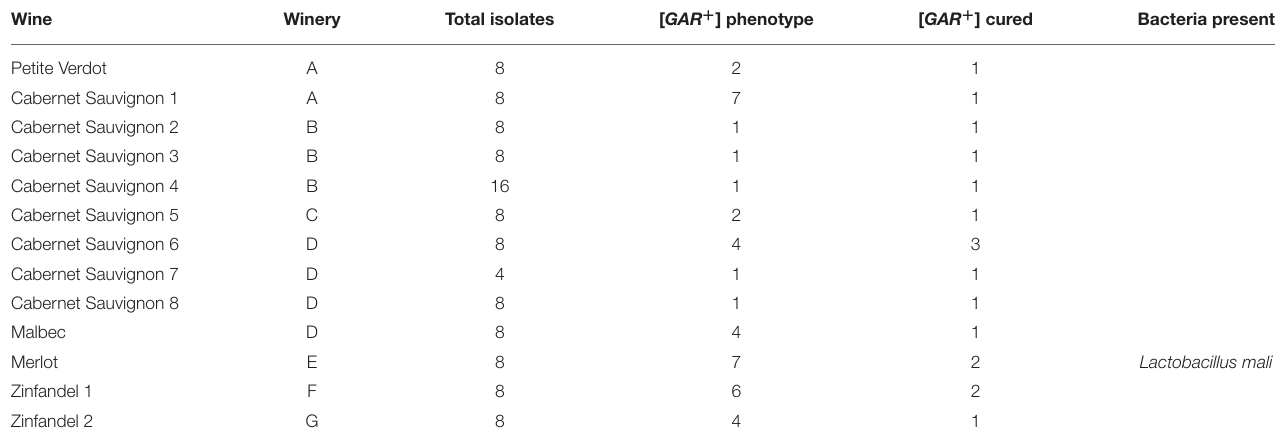
TABLE 2 | Summary of the curing of the [ GAR + ] prion in yeast isolates from arrested wines.